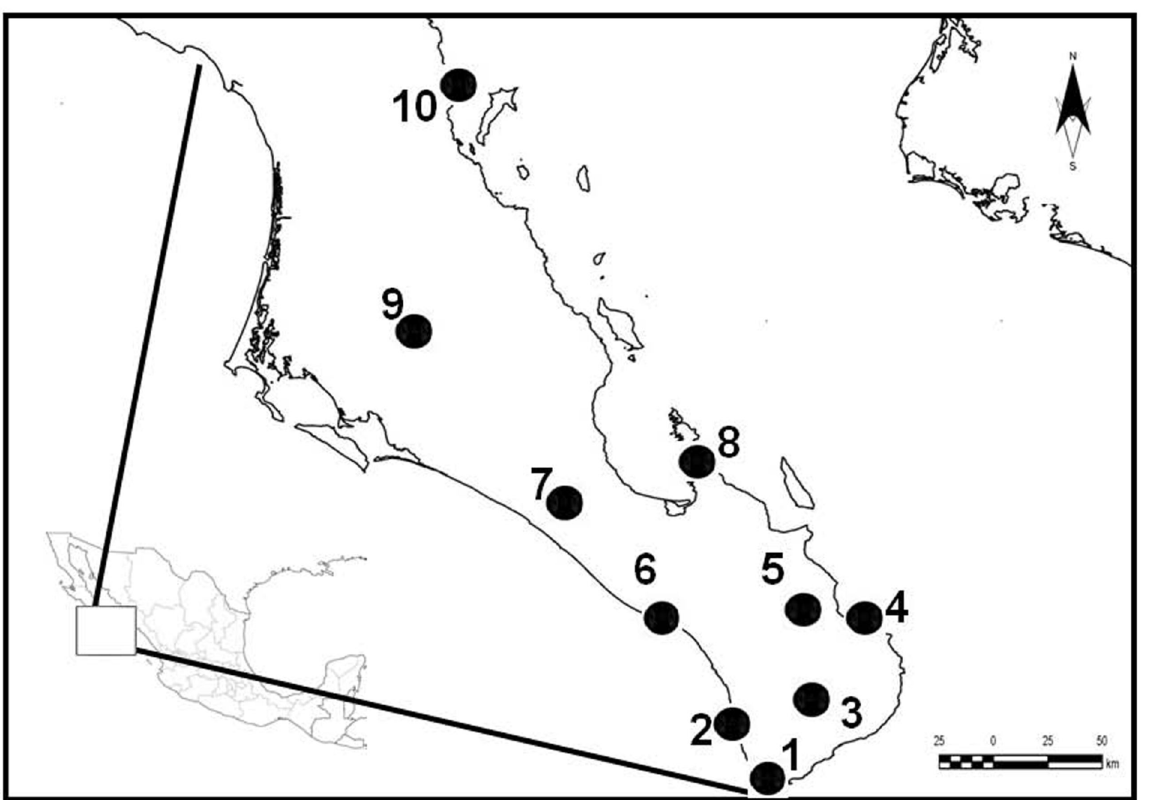
Fig 1. Map of the study area showing the sampled localities. 1: Cabo San Lucas (CSL). 2: Migri ñ o (MIG). 3: Camino de los Naranjos (CNAR). 4: La Ribera (RIB). 5; San Bartolo (BART). 6: Los Inocentes (INO). 7: Kilómetro 83 (KM83). 8: El Tecolote (TECO). 9: Presa de Ihuazil (IHU). 10: El Bajo